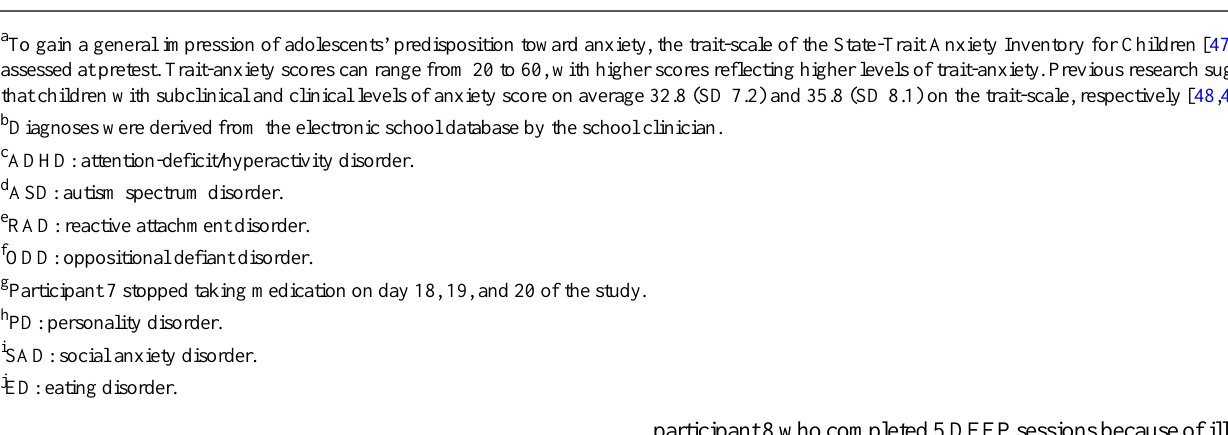
Table 1. All participants were of Dutch descent.